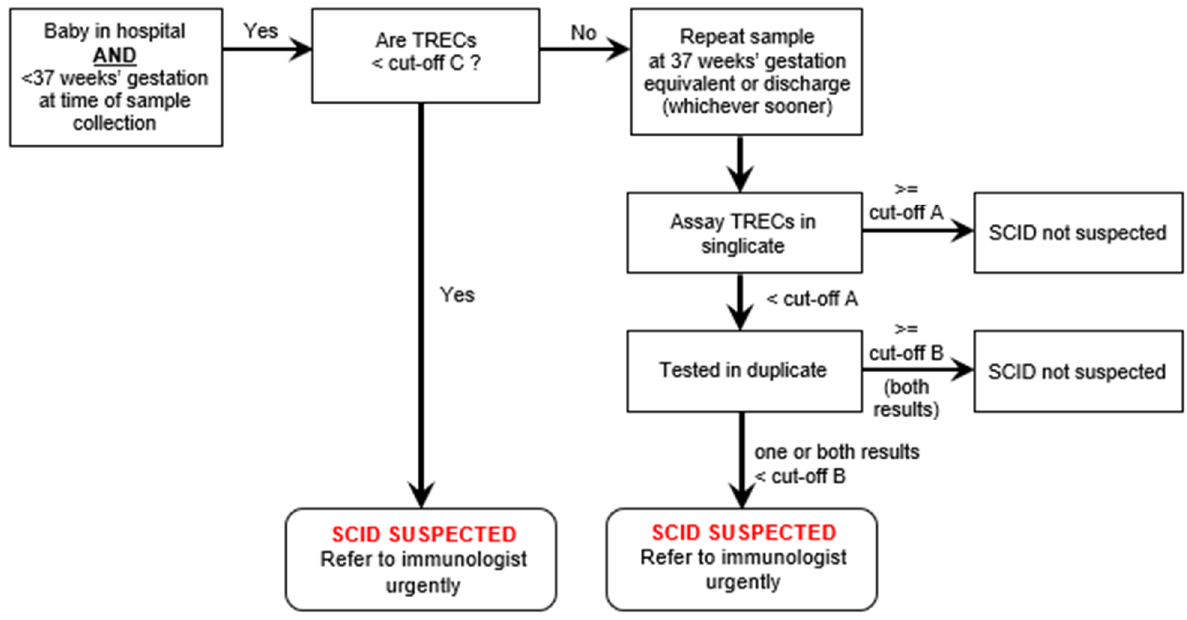
Figure 3. Pathway for premature babies found to have low TRECs on first assay.